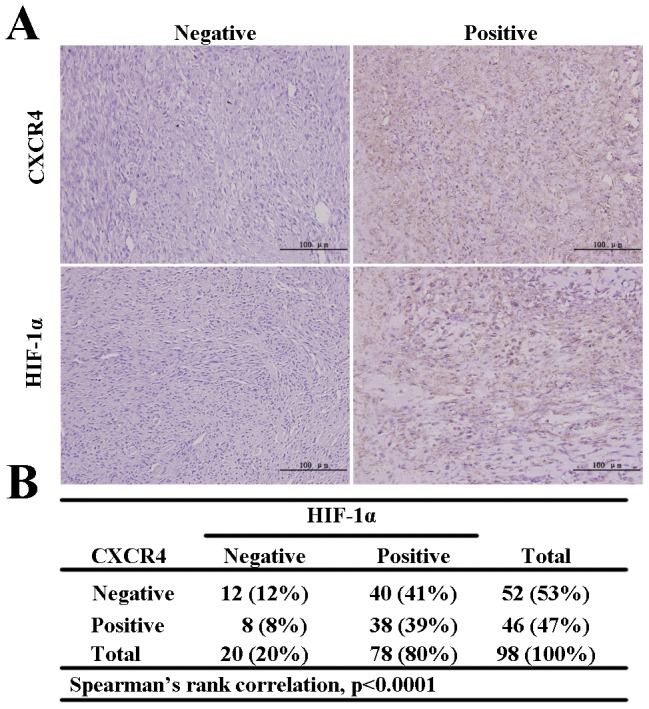
Expression of HIF-1α and CXCR4 in human osteosarcoma specimens.
A. The levels of CXCR4 (top) and HIF-1α (bottom) were analyzed in osteosarcoma tissues with immunohistochemical staining. Representative negative (left) and positive (right) images are shown (200×). B. Correlation between the expression of CXCR4 and HIF-1α in human osteosarcoma. Spearman's rank correlation, p<0.001.